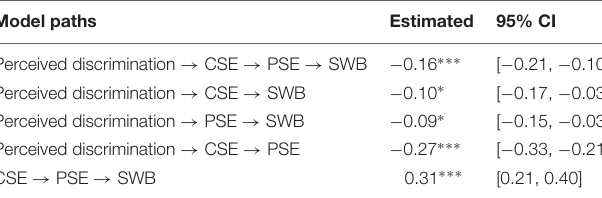
TABLE 3 | Bootstrapping results of the indirect effects in the final model. Model